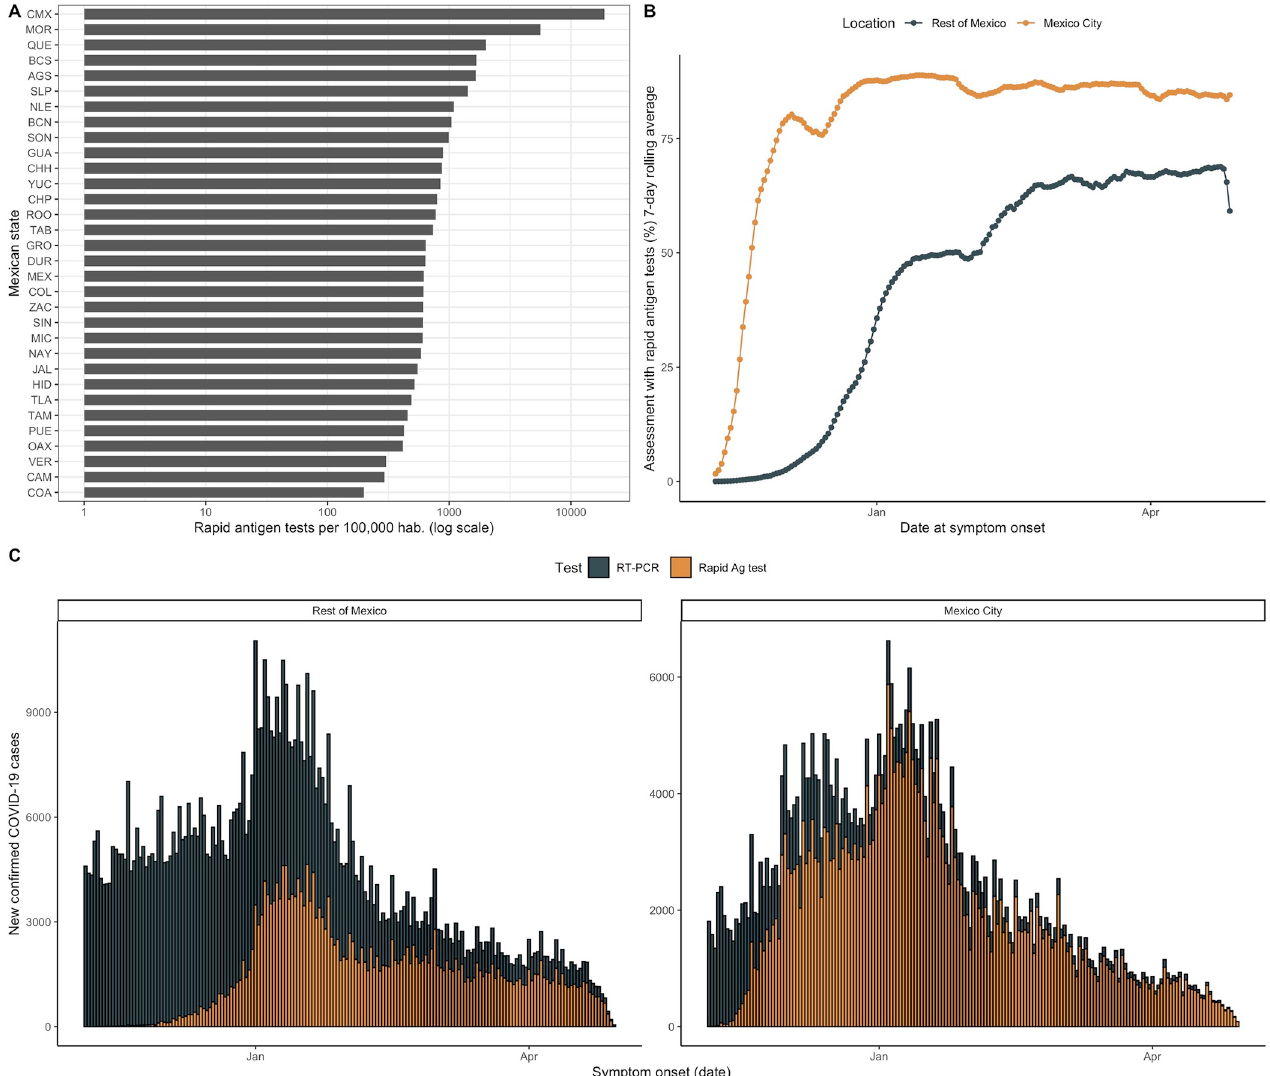
(21.17%) false negatives, 3,572 (1.84%) false positives and 41,050 (66.2%) true negatives, yield- ing and AUROC of 0.666 (95%CI 0.660–0.671). Overall, we identified that rapid antigen